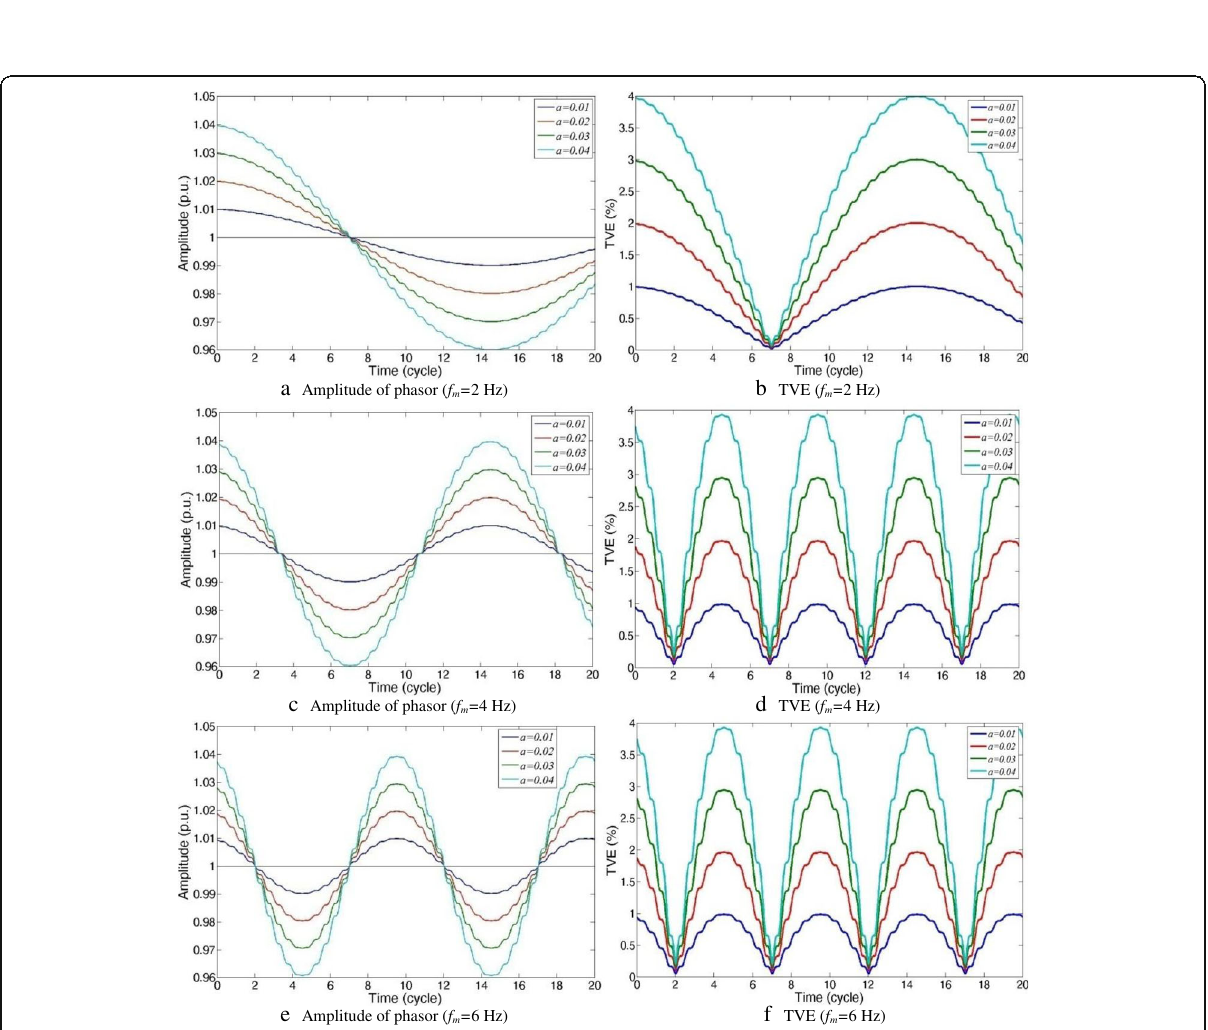
Fig. 12 Amplitude and TVE of phasor in amplitude modulation with different modulating factor and modulation frequency ( A = 1 p.u., f 0 = 60 Hz, φ 0 =